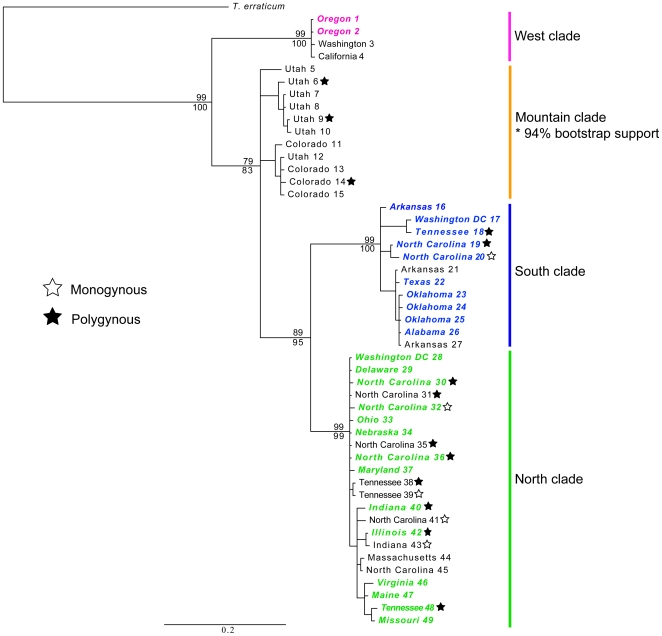
Fifty percent majority rule consensus tree from the Bayesian analysis.Numbers below branches indicate posterior probability values and numbers above indicate nonparametric bootstrap values from the Neighbor-Joining method. Only values >50% (or 0.5 posterior probability) are shown. Colors correspond to Figure 1. Samples denoted with a white star refer to monogynous colonies and black stars refer to polygynous colonies. Taxon labels in color represent urban samples.